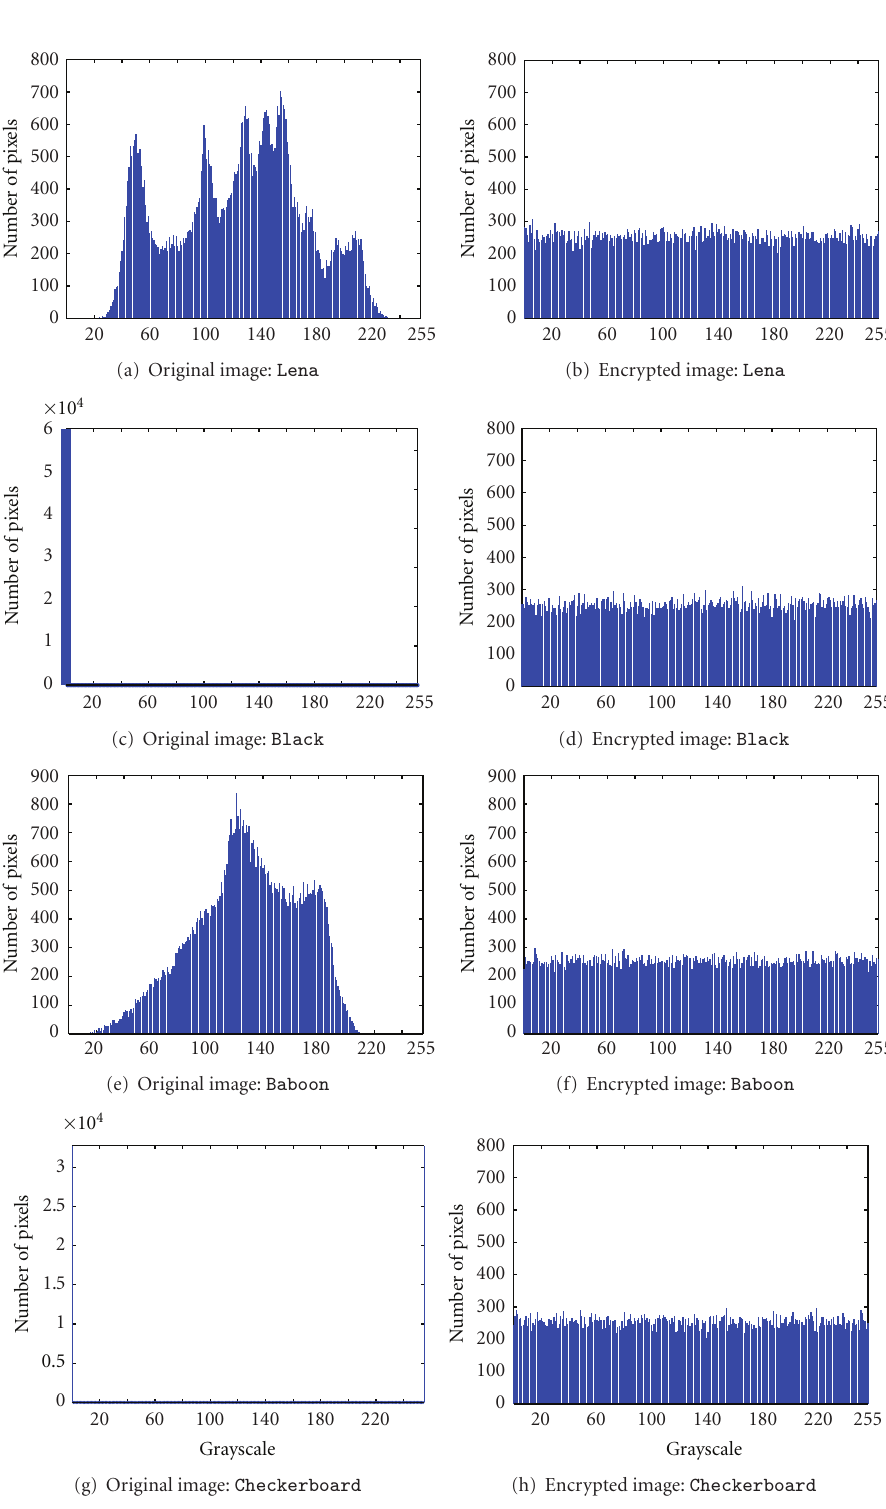
Figure 4: Histograms of original and encrypted